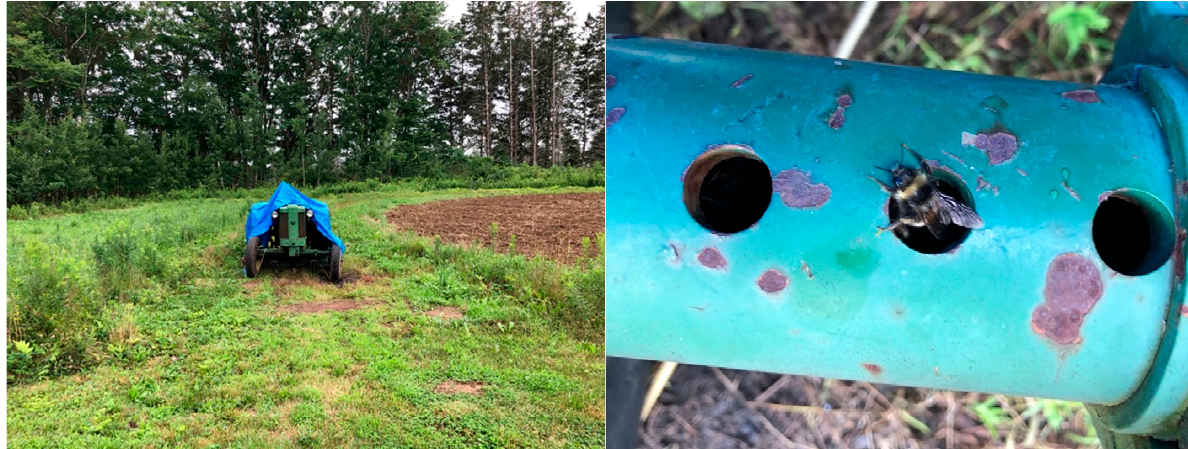
Figure 1. Immobile tractor in need of repair that queen found a hollow axle to nest in ( left panel ), and a closeup of a hollow front axle with B. terricola adult exiting nest ( right panel ).